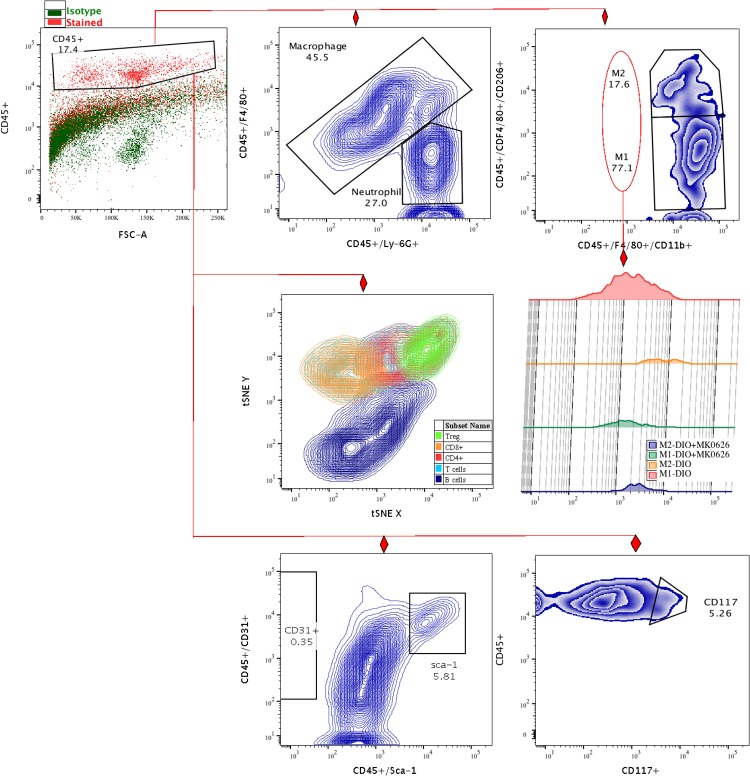
Flow cytometric gating strategy of ischemic tissue infiltrated cells.The numbers of recruited total T-cells (CD45+/CD3e+), subsets of T-helper cells (CD45+/CD3e+/CD4+, P < 0.02), and cytotoxic T-cells (CD45+/CD3+/CD8a+, P = 0.2) significantly decreased, while the frequency of regulatory T-cells (CD45+/CD4+/CD25+) tended to increase in the MK-0626-administered DIO group, in comparison with DIO group (Fig 6H–6K). In tSNE analysis, B-cell (CD19+) recruitment into the LHI tissue showed an upward trend in the DIO group, in comparison with the MK0626-administered DIO group, although this difference was not statistically significant (P > 0.11) (Fig 6L). t-SNE; t- distributed stochastic neighbor embedding.